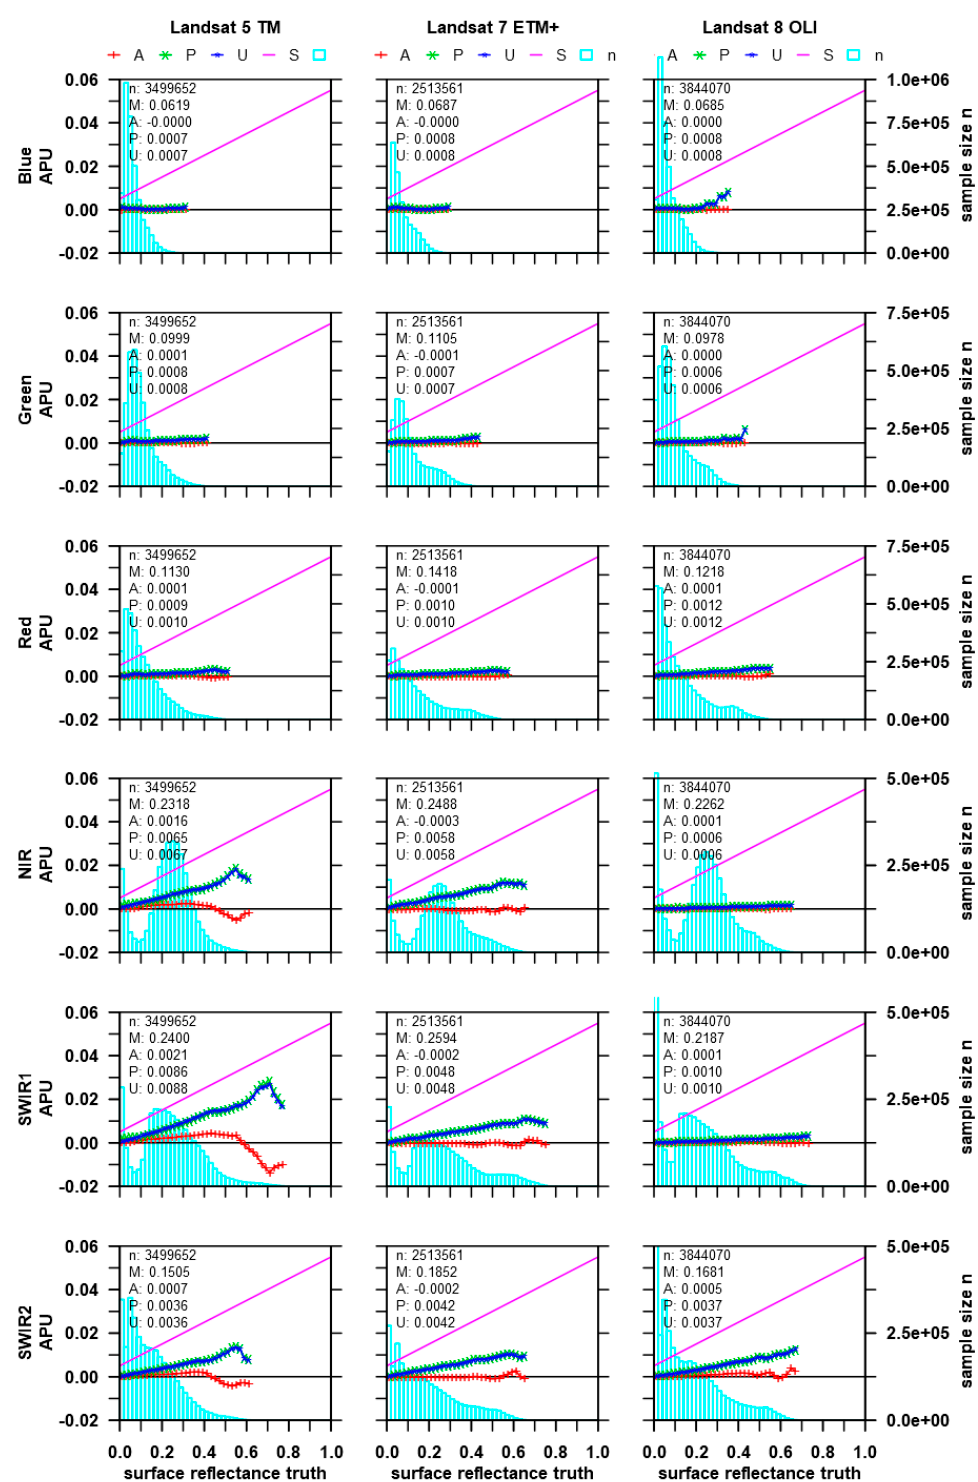
Figure 8. Accuracy, precision, and uncertainty (APU, left y-axis) for all Landsat sensors and bands. Sensors are arranged in columns, and the 6 Landsat heritage bands in rows. The reference reflectance (truth) was obtained using daily water vapor values, and the estimated reflectance was derived using the water vapor climatology. The cyan bars are the number of samples for each 2% reflectance bin (right y-axis). M is the average surface reflectance truth. A (red line), P (green), and U (blue) were calculated for each bin (lines) and for all samples in total (legend). APU should not exceed the theoretical specification, i.e., they should remain under the magenta